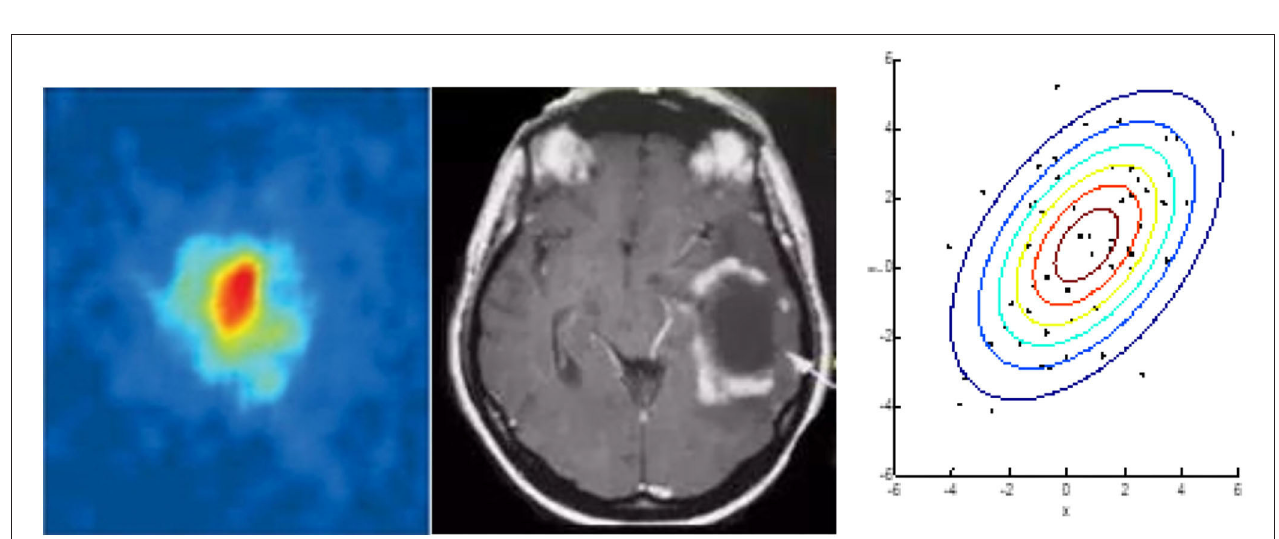
FIGURE 5 | BEC kernel and Gaussian kernel with SVM for random nodes. (A) BEC kernel. (B) Gaussian kernel.